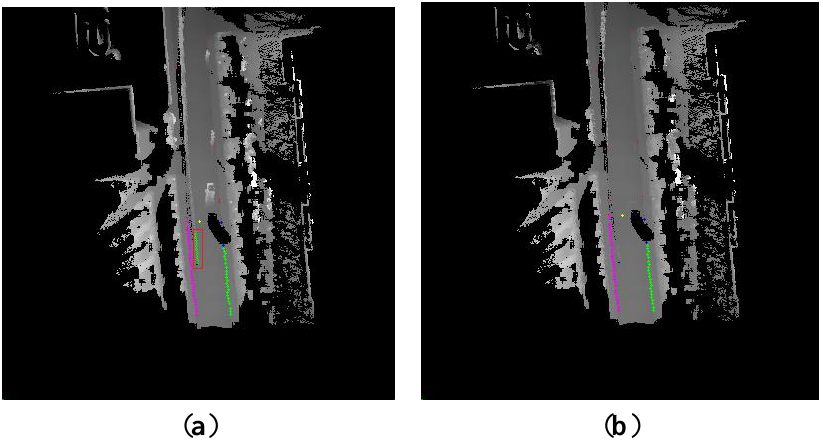
Figure 14. The contrastive result of the curb detection. ( a ) The bad curb detection result. ( b ) The result of our method.